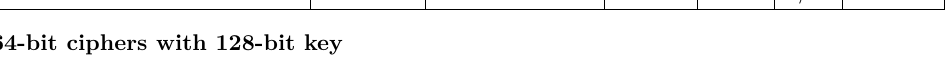
Table 5: Masked constant-time implementation results of GIFT and AES on ARM Cortex- M4. For encryption routines, speed is expressed in cycles per block. Emboldened (resp. italic) results refer to speed (resp. code size) oriented implementations.